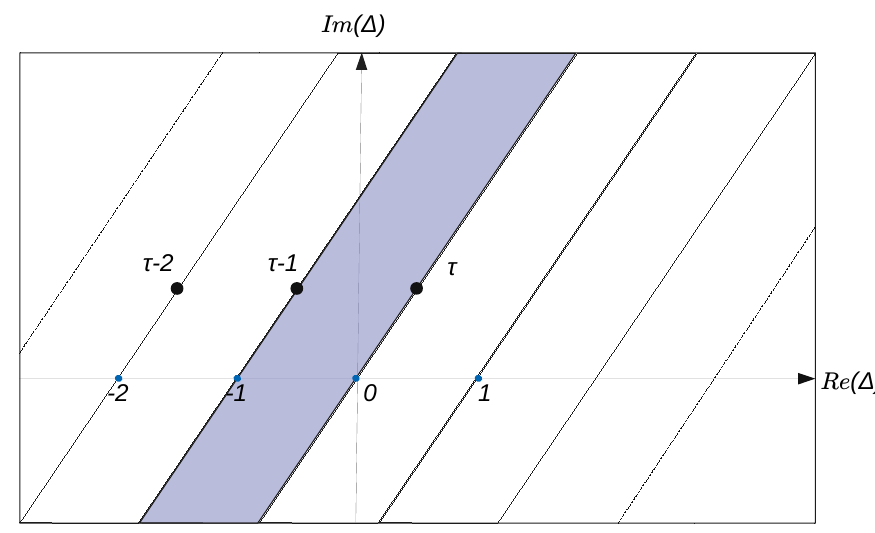
Figure 1 . The (cid:12)gure shows the complex plane of chemical potentials for a generic (cid:1) where the region speci(cid:12)ed by (3.2) is shown in